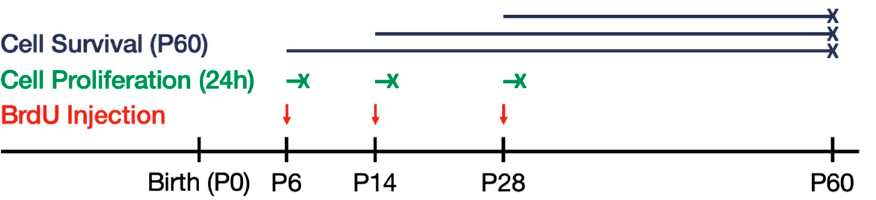
Figure 1. Experimental timeline of bromodeoxyuridine (BrdU) injections and endpoints used to assess cell proliferation and survival. Male and female WT and ZnT3 KO mice ( n = 144) were assigned to postnatal day (P) 6, 14, or 28; at which point, two subcutaneous injections of BrdU (50 mg/kg) were administered at approximately 09:00 and 11:00 h (indicated by red arrow). To assess the cell proliferation, half of the mice from each group were killed approximately 24 h after the last injection (indicated by green -x). The other half were left to survive until P60 to assess the cell survival (indicated by blue -x).